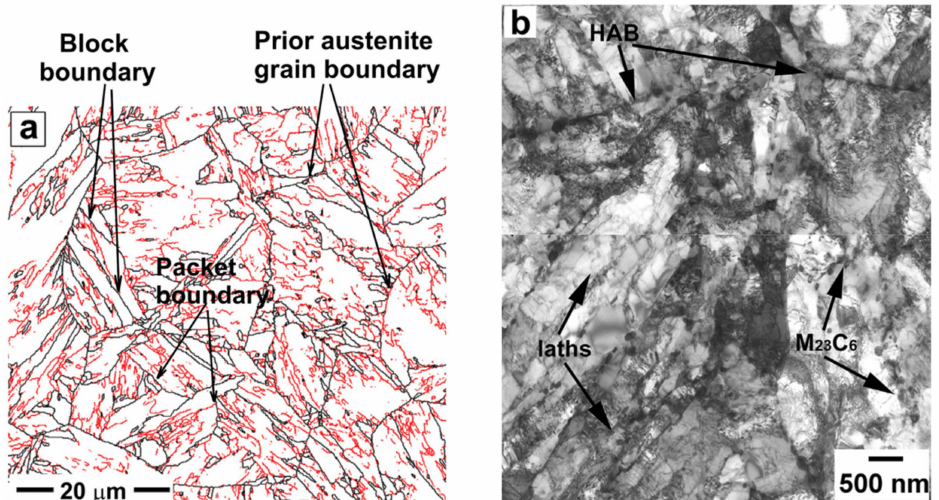
Figure 1. Typical hierarchical microstructure in 9–12% Cr steels on the example of boundary map of the as-tempered 10Cr steel (black and red lines correspond to high-angle and low-angle boundaries, with misorientations of θ ≥ 15 ◦ and 2 ◦ ≤ θ < 15 ◦ , respectively), showing the prior austenite grains divided on blocks and packets with martensite laths ( a ). TEM micrograph showing the laths structure with high dislocation density and precipitated M 23 C 6 carbides on the lath boundaries and high-angle boundaries (HABs) ( b ). Reprinted with permission from Ref. [8]. Copyright 2019